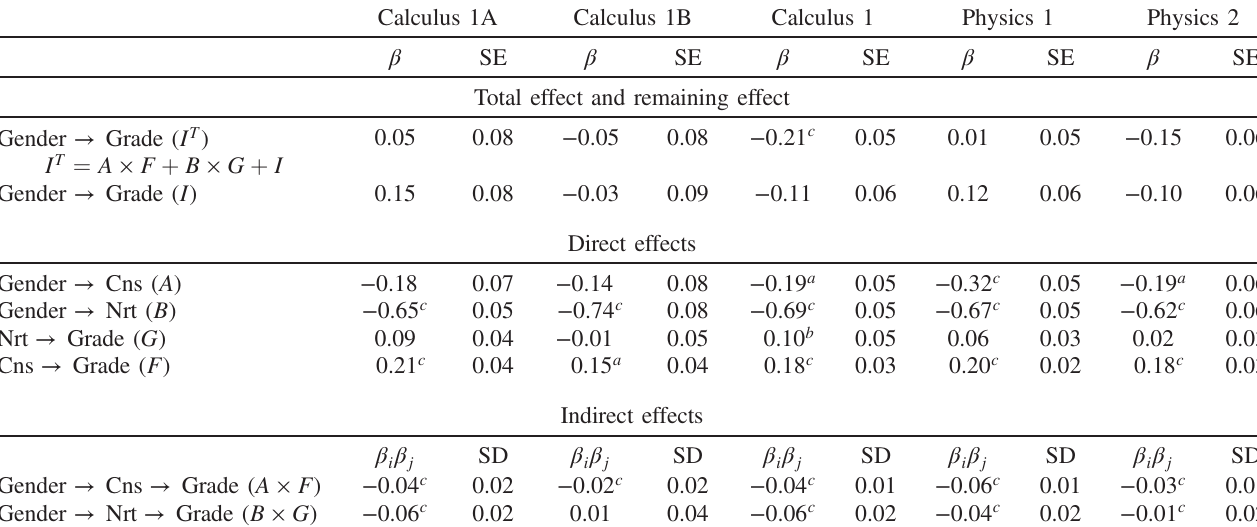
TABLE III. The mediation by neuroticism and conscientiousness of the relation of gender to grade. The regression coefficient β and its standard error are presented. Women are coded as zero, men as one. For indirect effects, the product of the path coefficients β presented and the standard deviation of the product. Conscientiousness is abbreviated Cns, neuroticism Nrt, and self-efficacy SEF. Note that “ a ” denotes p < 0 . 05 , “ b ” p < 0 . 01 , and “ c ” p < 0 . 001 . A Bonferroni correction was applied to the significance